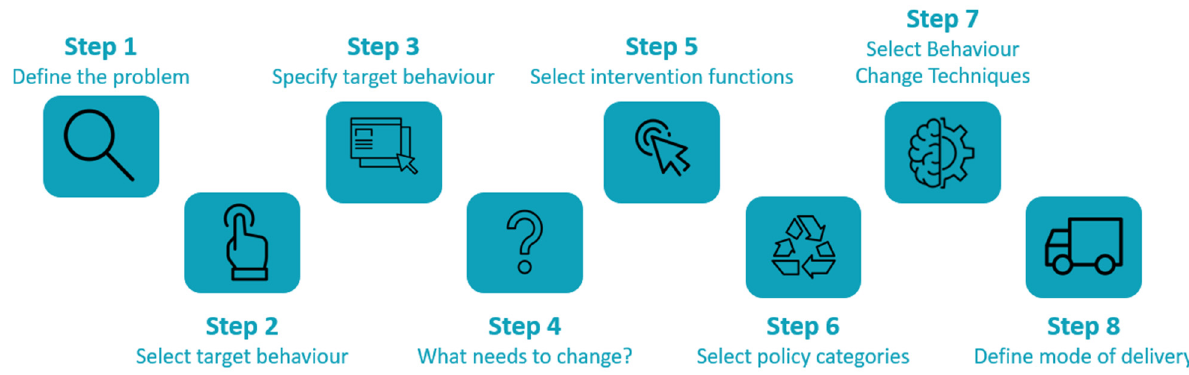
Figure 2. The eight steps of the Behaviour Change Wheel used in the GRANDPACT co-creation trajectories.